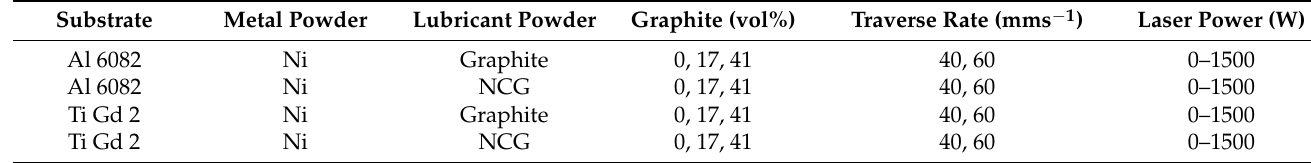
Table 2. Parameters for single line deposition trials.